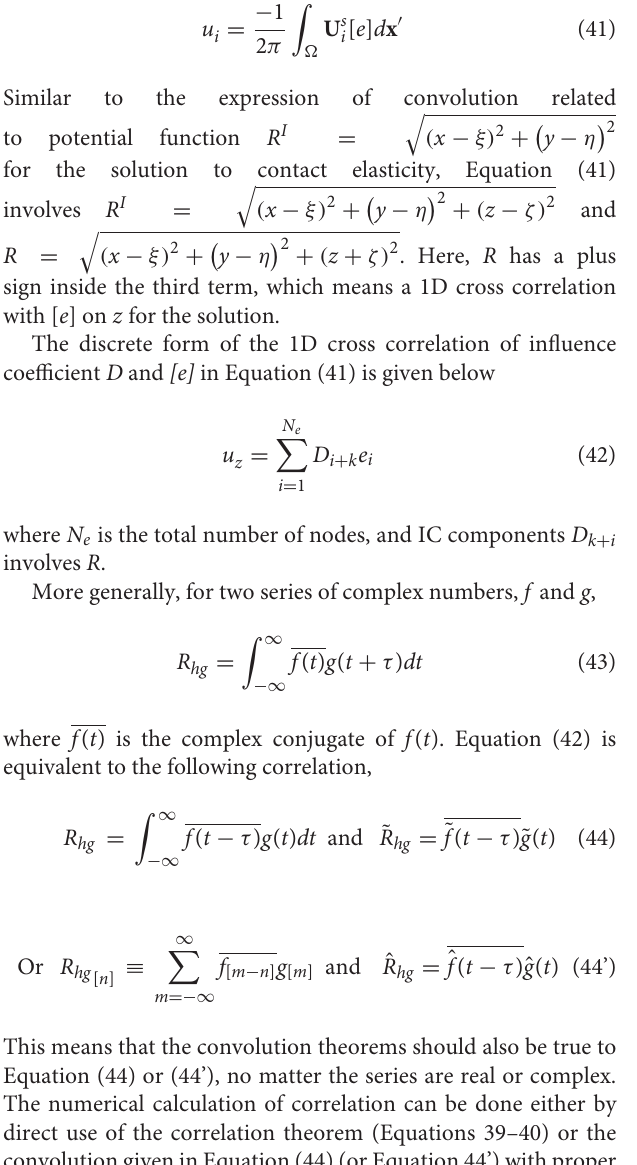
300 mm and R y = = 500 N. More details =